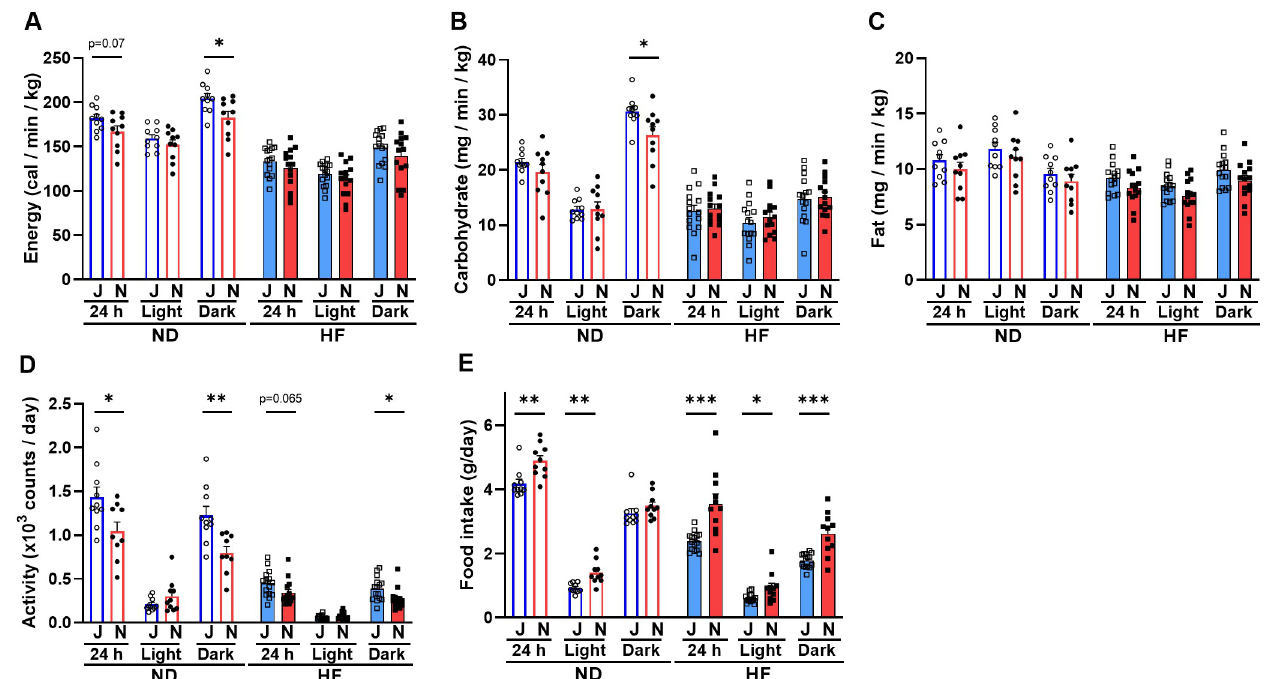
Fig 5. Differences in metabolic assessments between B6J and B6N mice. (A) Energy expenditure (B) Carbohydrate consumption (C) Fat consumption (D) Activity, and (E) Food intake. Values are means + SEM (n = 5, experimented in duplicates), and asterisks ( � ) indicate significant differences ( � p < 0.05, �� p < 0.01, and ��� p < 0.001, unpaired Student’s t -test). Open circles, ND-fed B6J; filled circles, ND-fed B6N; open squares, HF-fed B6J; filled squares, HF-fed B6N.